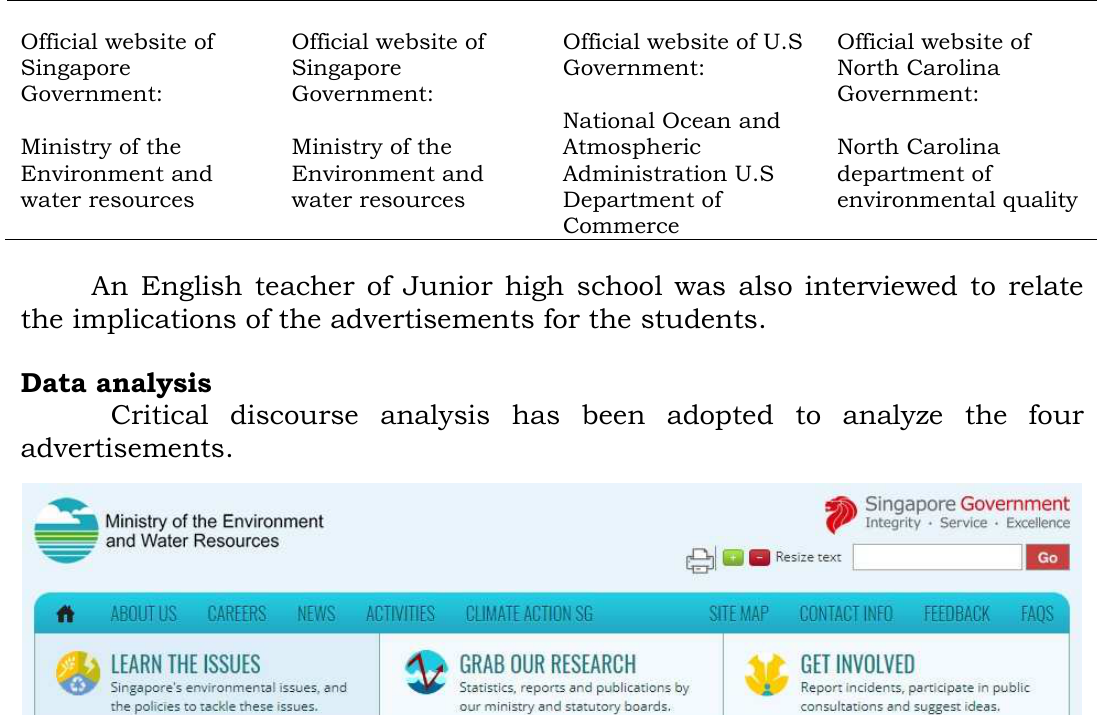
Table 1. Resources of